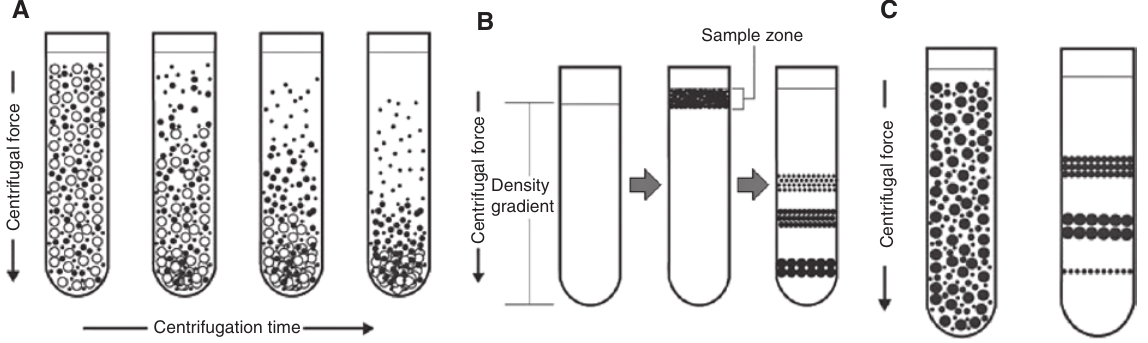
Figure 1: The principle of differential (A), rate-zonal (B), and isopycnic (C)